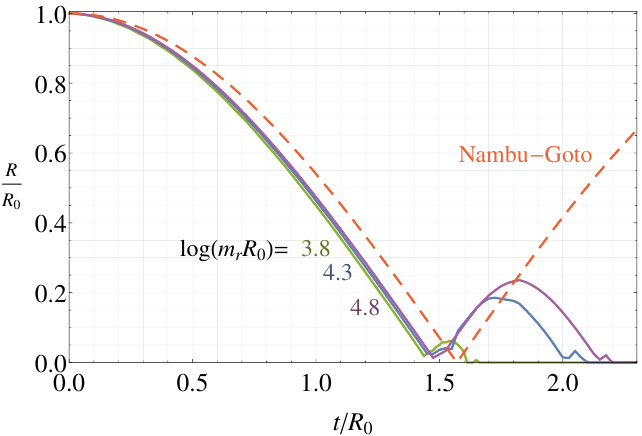
Figure 20: The radius R ( t ) vs time for circular loops, normalized to the initial ra- dius R . The different lines correspond to different values of the initial log ( m 0 The dashed red line is the free Nambu–Goto solution R ) grows, the time-law R ( t ) approaches the Nambu–Goto limit, and the loop R log ( m r 0 tends to bounce more. This is in agreement with the picture proposed in [ 36 ]